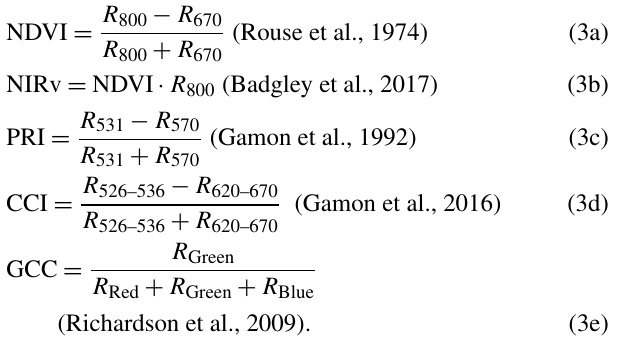
Figure 1. (a) Seasonally averaged canopy reflectance in winter dormancy (red) and the growing season (black) from PhotoSpec. (b) Seasonally averaged negative logarithm transformation of re- flectance (400–900nm). For comparison, we normalized the re- flectance by the value at 800nm on each day. Here, we referred to 13 November–18 April as dormancy, and 2 June–21 August as the main growing season. The seasonal averaged canopy reflectance is composed of 39 daily-average reflectance in the growing season and 113 daily-averaged reflectance in the